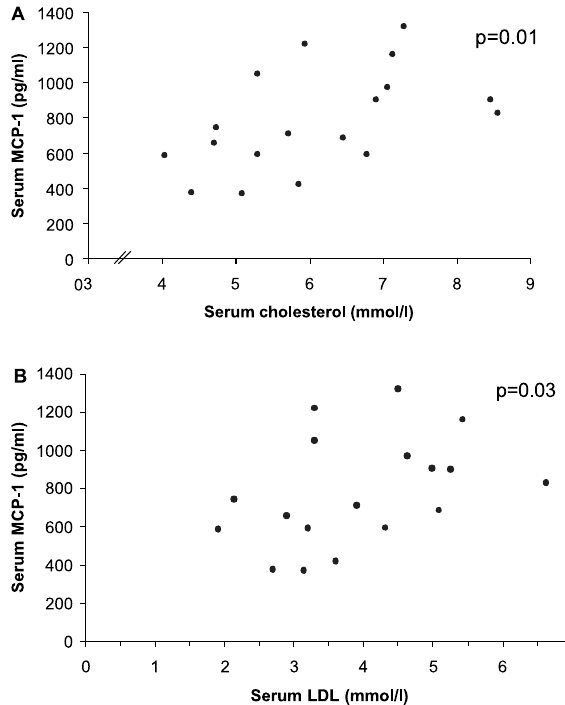
FIG. 2. Relationship between serum MCP-1 and serum cholesterol (A) or LDL (B). Circles, individual values of 18 patients. pvalues are based on the values of the Spearman correlation